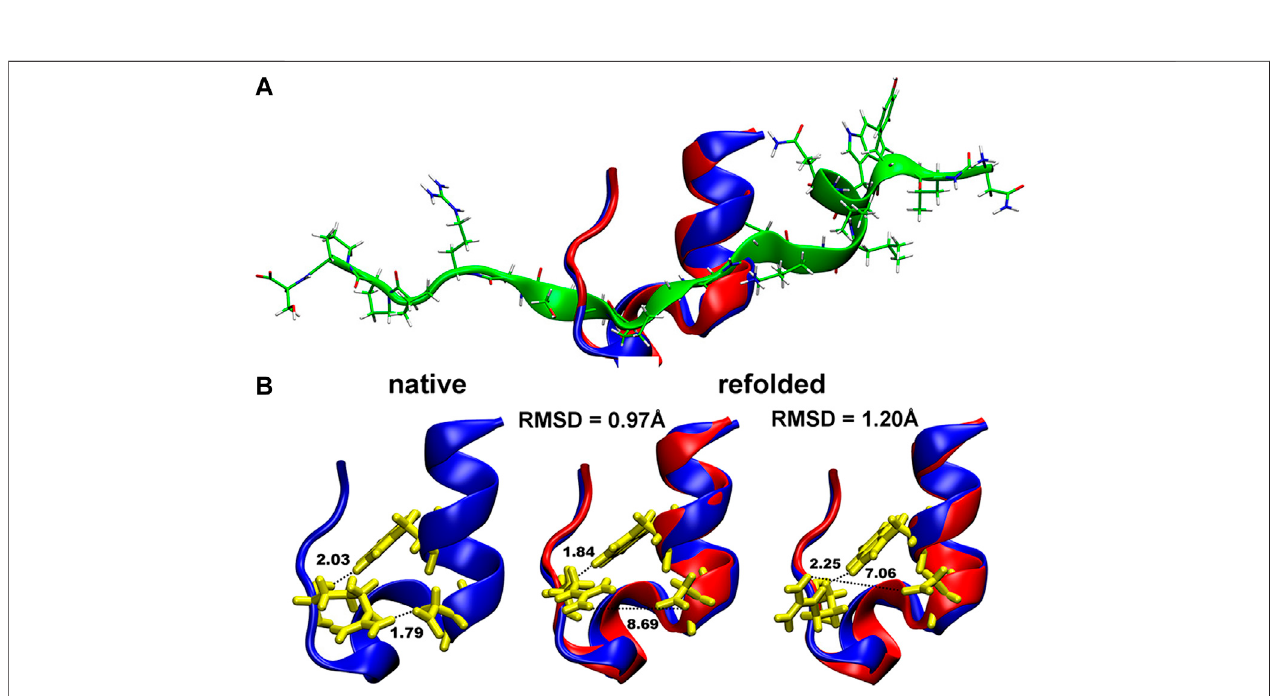
FIGURE 7 | (A) Folding of the Trp-cage miniprotein (1L2Y) in MC simulations in SIMONA: Overlay of the native structure (in blue) and the refolded structure (in red) obtainedinMCrunat370Kstartingfromunfoldedproteindepictedingreen (B) ,Structuresofthenative1L2YandrefoldedlocalminimawithdifferentRMSDandformed hydrogen bonds (described in the text). Graphics reprinted from Heilmann et al. Sci. Rep. 10, 18211 (2020) under Creative Commons Attribution 4.0 International License [52].